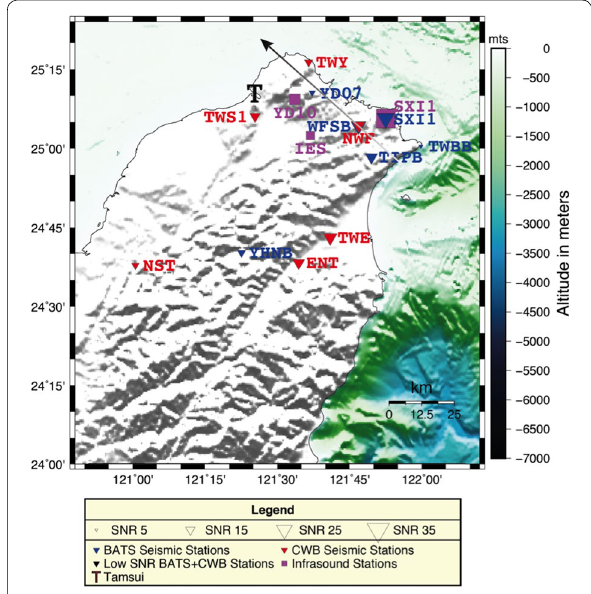
Fig. 1 Distribution of the seismic and infrasound stations that recorded the clear shockwave signals on December 5, 2013. The stations are presented in red (Seismic; CWB), blue (Seismic; BATS), and magenta (Infrasound; IES) triangles . The size of the triangle represents the SNR. The location of Tamsui township is marked with a bold “ T. ” The arrow indicates the solved trajectory of the meteor; the tip of the arrow points to the estimated intercept point of the protracted meteor trajectory with the ground surface (Additional file 1: Table